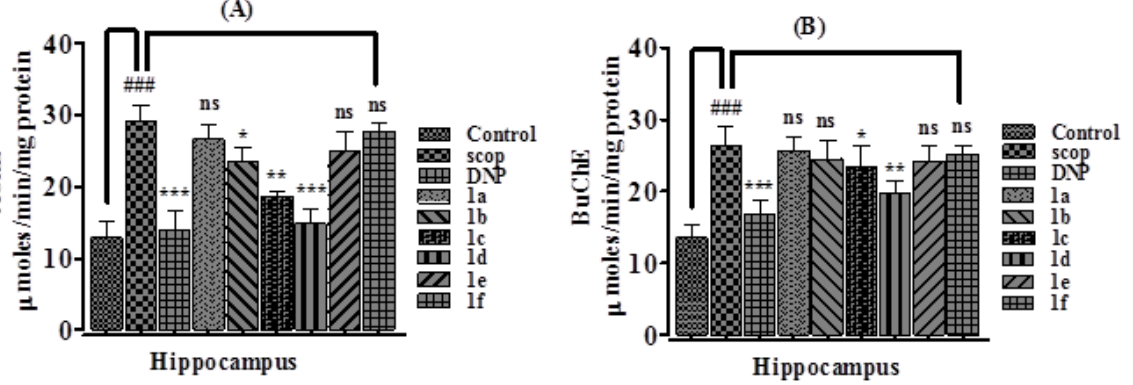
Figure 5. Ex vivo anticholinesterase effect of synthesized curcumin analogs ( 1a–1f ) in AChE ( A ), BChE ( B ) in the hippocampus region of mice brains versus scopolamine treated group. Data were presented in (mean ± SEM), n = 6. ###P ˂ 0.001 vs. normal control. Significantly different values were compared with amnesic group; ***, **, * and ‘ns represents p -value ˂ 0.001, ˂ 0.01, ˂ 0.05, ˃ 0.05 respectively.